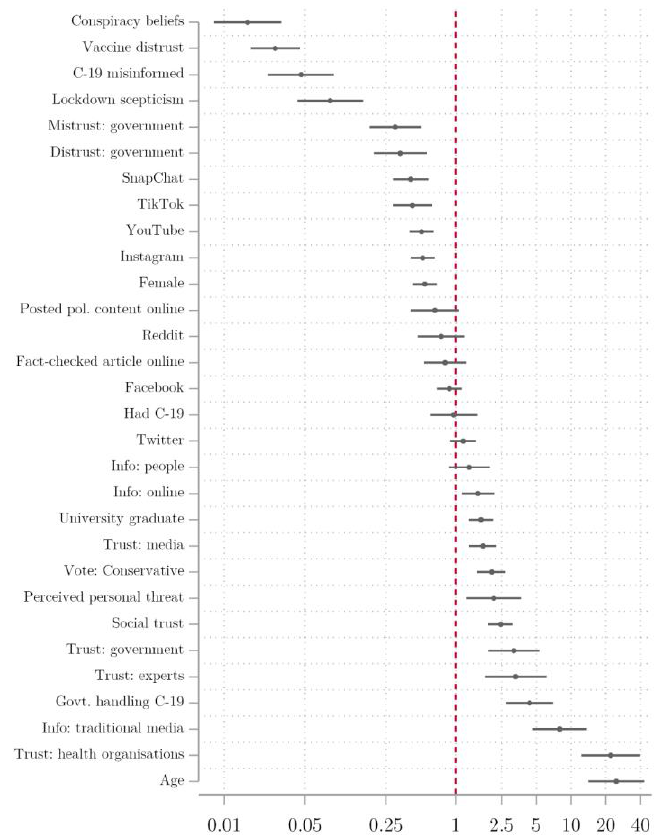
Figure 1. Bivariate logistic regression of vaccine willingness, odds